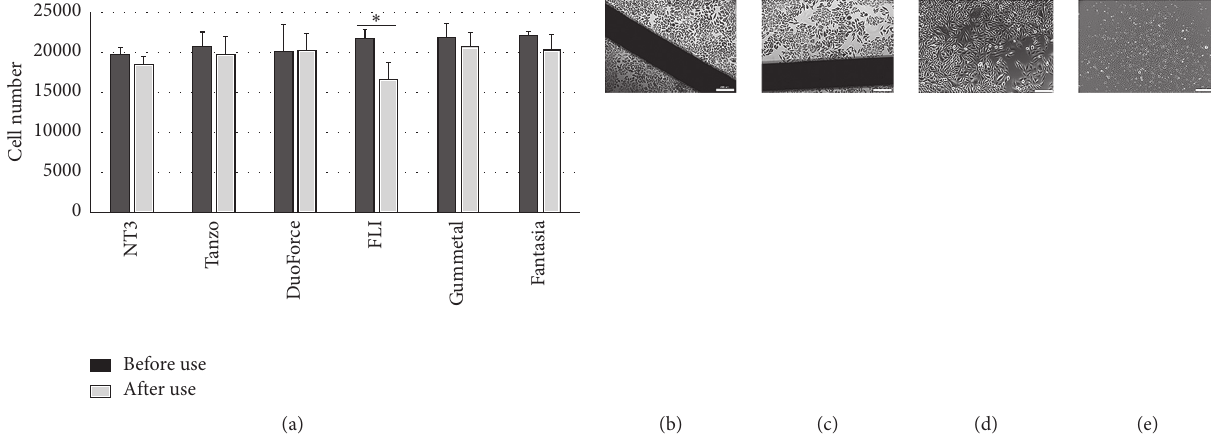
Figure 1: Cell viability (a). Number of fibroblasts obtained after cell culture with each type of wire, before or after use in the mouth. The FLI wire was the only one that produced a significant reduction in cell viability after use in the mouth ( ∗ p ≤ 0 . 05). Photomicrographs of human gingival fibroblasts: HGF were observed in contact (72h) with the NT3 wire before (b) and after use (c) in the mouth. Similar images were obtained with the other wires studied. The positive viability control corresponded to cells without contact with the wire (d), and the negative viability control was cells treated with Triton X-100 (e). Bar: 200mm. Table 2: Number of living-HGF cells exposed to different wires, before and after being used in the mouth, and percentage of cytotoxicity after 72h. Before-use group After-use group Orthodontic wires Cytotoxicity (%) p value Live cells mean ± SD